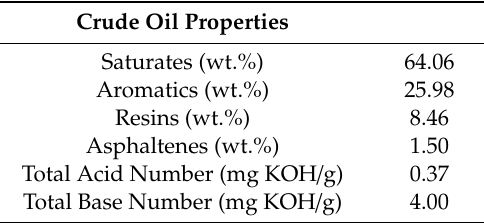
Table 2. Crude oil